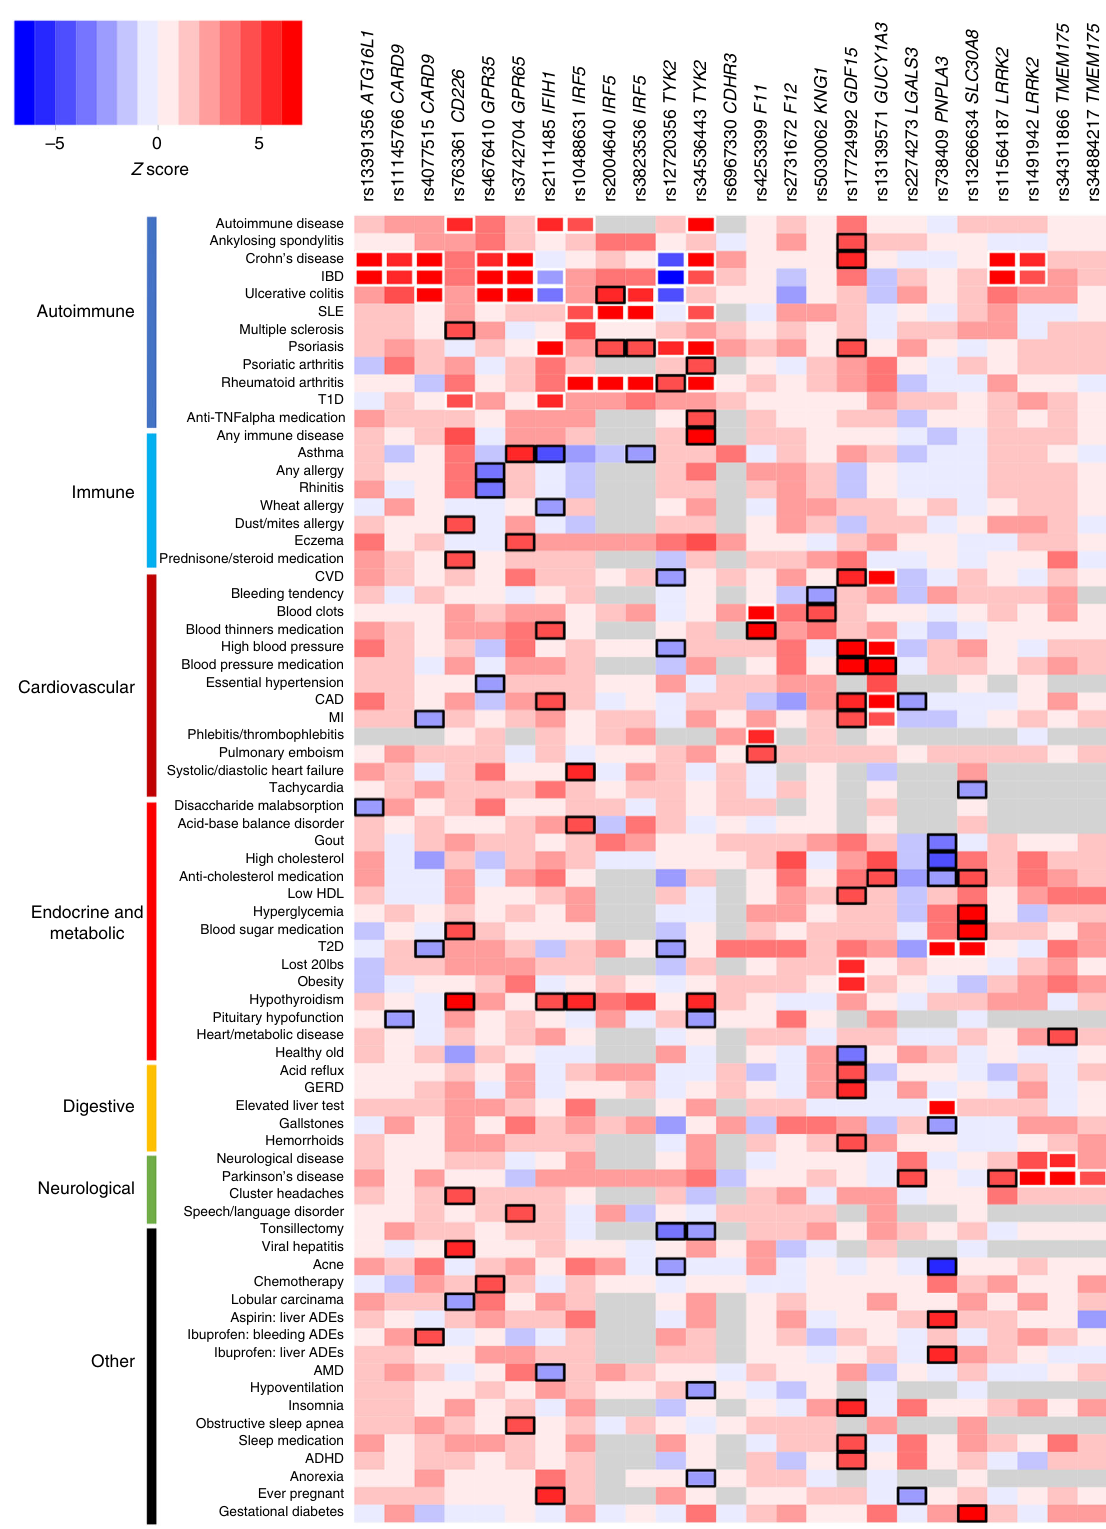
Fig. 2 Meta-PheWAS results for 25 SNPs in candidate drug targets. Phenotypes associated at FDR < 0.1 ( P < 7e − 4) with at least one SNP in the meta- PheWAS are represented. Direction of effect of the known disease-risk increasing allele related to the therapeutic hypothesis is indicated. A positive Z score (in red) indicates increased risk, a negative Z score (in blue) indicates reduced risk. Known and novel associations reaching FDR < 0.1 are outlined in white and black respectively. Detailed association results are provided in the Supplementary Data